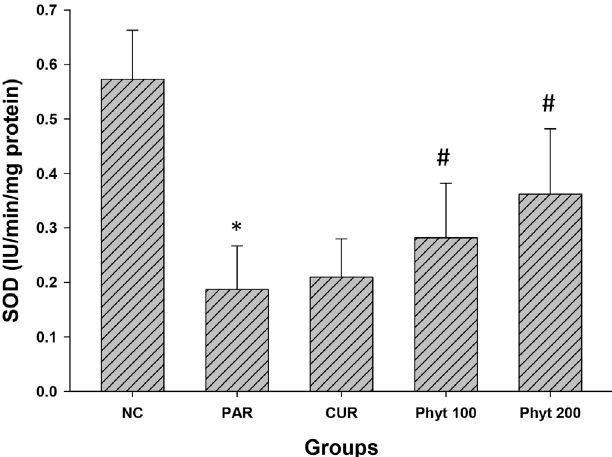
FIGURE 10 - Effect of phytosome curcumin on SOD activity of control and treated animals in paracetamol-induced liver injury in mice. Value represents as mean ± S.D. * p<0.05, significant difference compared with control group, # p<0.05, significant difference compared with paracetamol group ( n = 10).